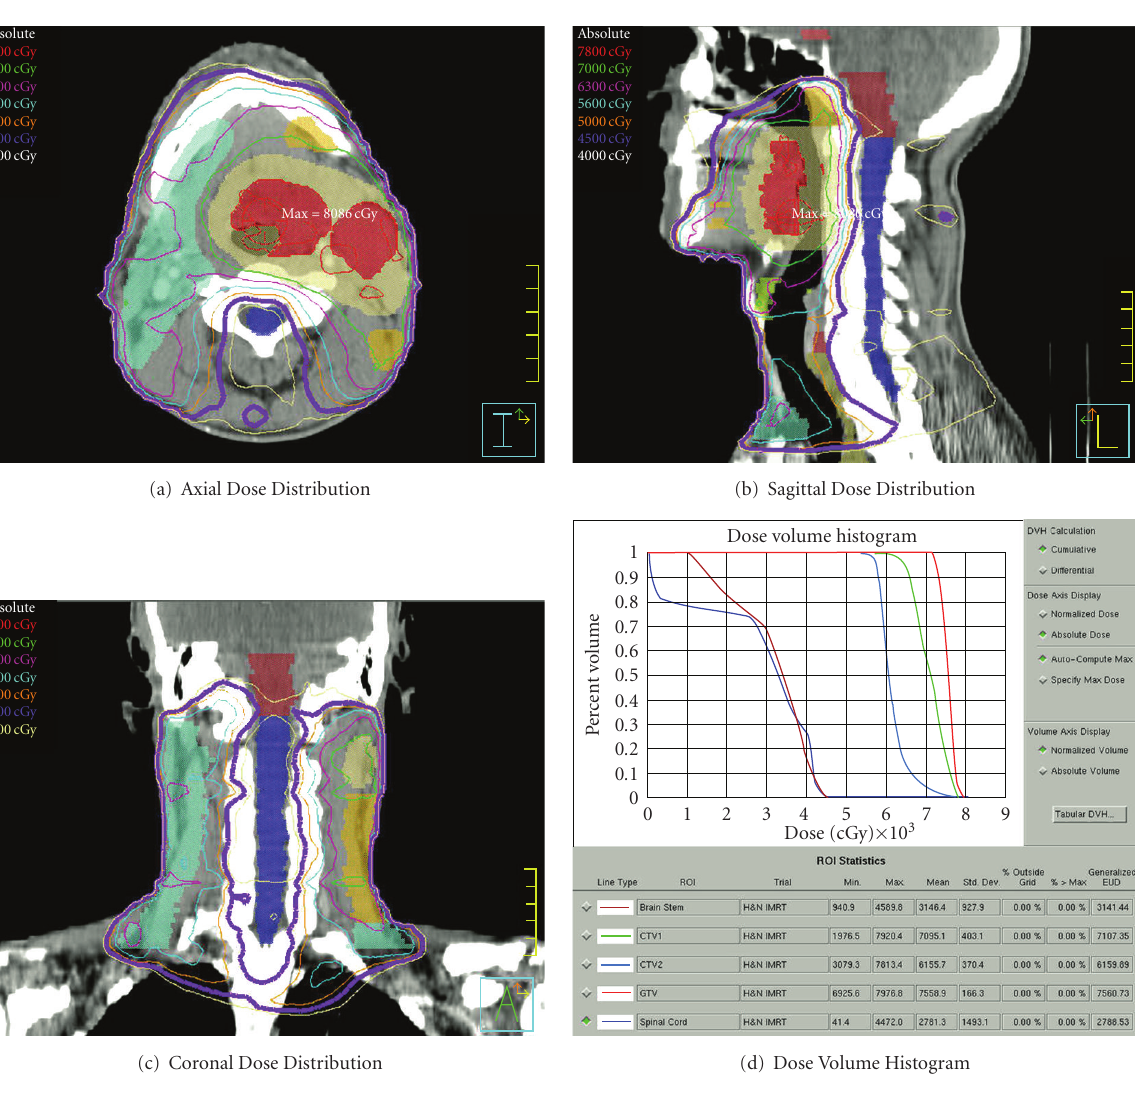
Figure 1: Radiation dose distribution as represented by radiation isodose lines displayed in the (a) axial, (b) sagittal, and (c) coronal planes. The thick purple line represents the 4500 cGy isodose line. The dose volume histogram (d) graphs the percent volume of structure or target receiving a radiation dose. Radiation targets including the red gross tumor volume (GTV), the beige expansion of GTV (CTV1), the yellow high-risk clinical volume (CTV2), and light blue low-risk clinical volume (CTV3) are included with the critical normal structures of spinal cord and